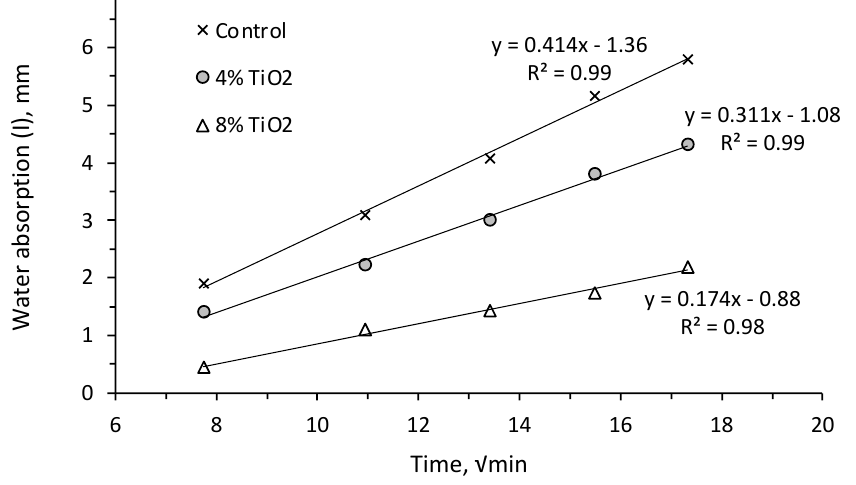
Figure 8. Typical variations in water absorption over time for selected slurries.